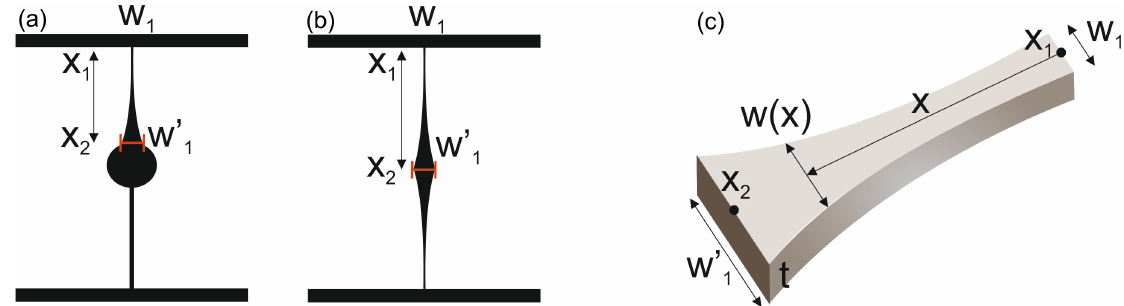
Figure 5. Depiction of the layout for a parabola-shaped transmission electrode: ( a ) orthogonal and ( b ) voltage divider configuration. ( c ) Three-dimensional schematic the parabola-shaped transmission electrode.